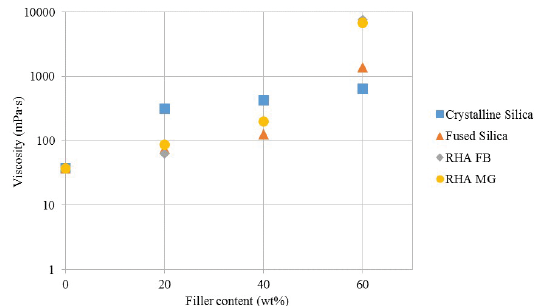
Figure 1. Effect of filler amount on the viscosity of mixtures (m Pa